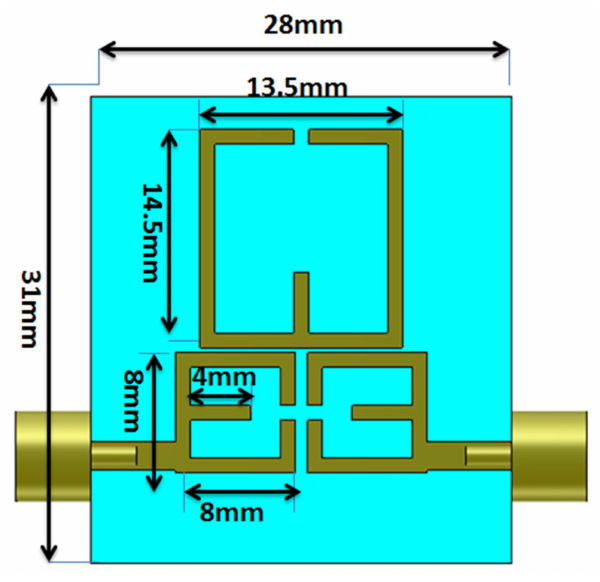
Figure 7. Third-order OLR with stub band-pass filter.